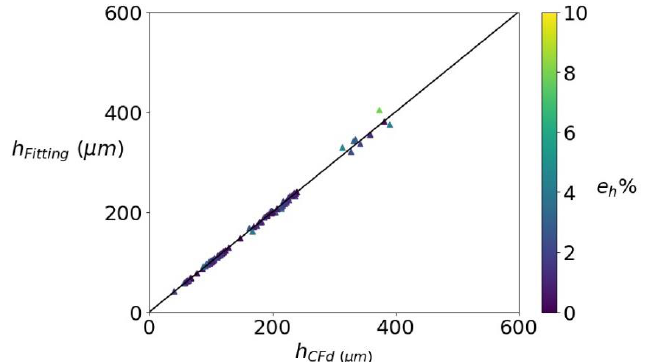
Figure 17. Comparison between the height of a deformed droplet obtained using CFD simulations and fitting.